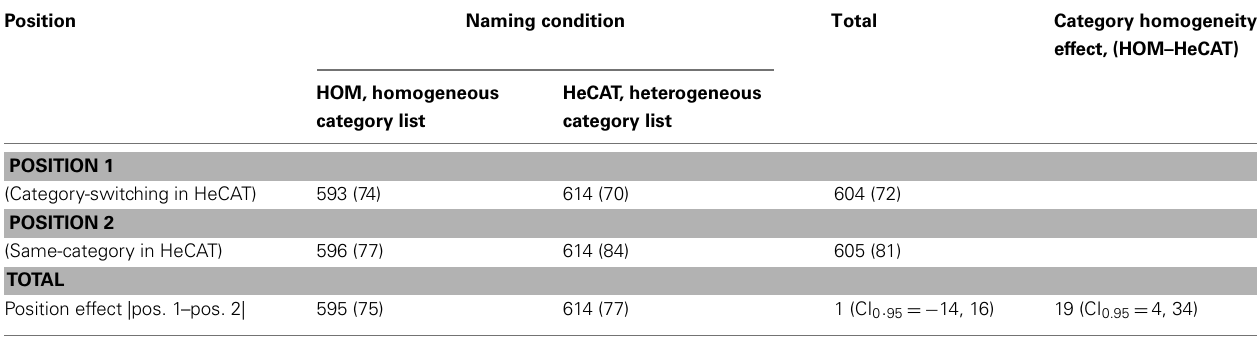
Table 2 | Results of Experiment 5 (picture naming with written word